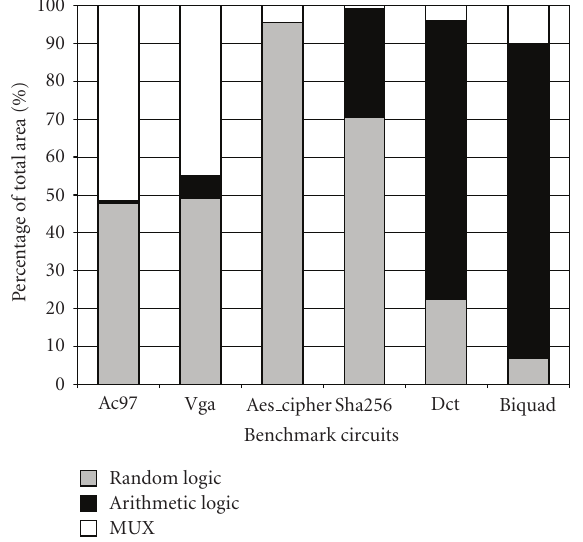
Figure 2: Synthesis results of six benchmark